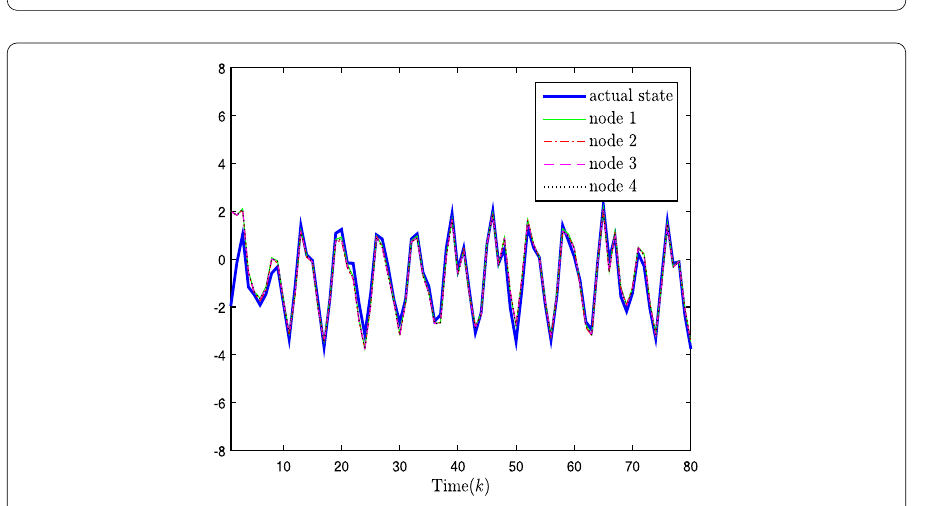
Figure 9 The actual state x 2, k and the corresponding estimates